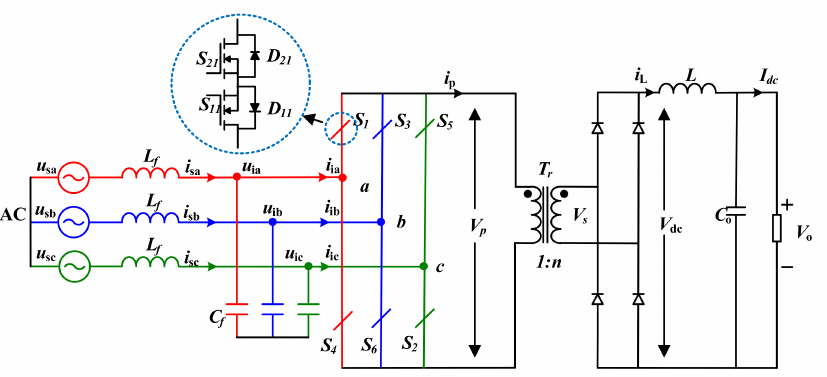
Figure 1. The schematic diagram of three-phase isolated matrix